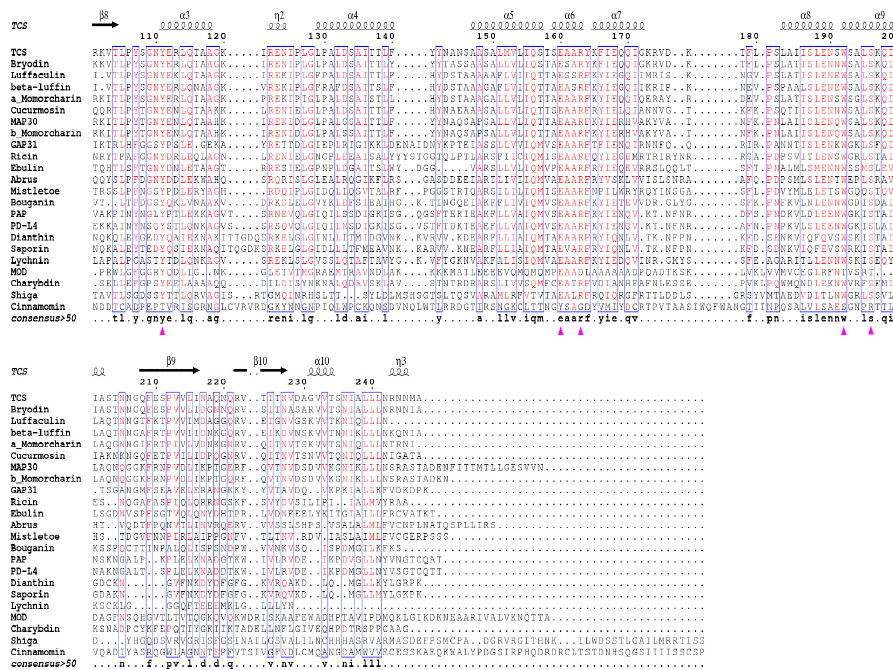
Figure 4. Structure based sequence alignment of structurally known RIPs. The catalytic A chains of all type 2 RIPs were used for sequence alignment. The sequence alignment was prepared by ENDscript 2 web server [40]. The conserved key residues of the active pocket of TCS (Y70, Y111, E160, R163, and W192) are marked with purple triangles. The top secondary structure elements are shown according to the crystal structure of TCS. The consensus sequences are highlighted with blue rectangles (consensus value >50%), the highly conserved residues are colored in red.